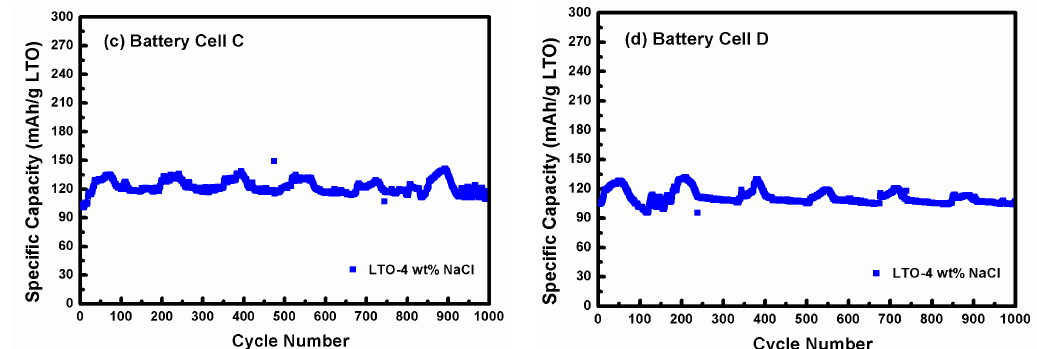
Figure A3. Cycle performances of various LTO-4 wt % NaCl / LFP battery cell at 10 C-rate.